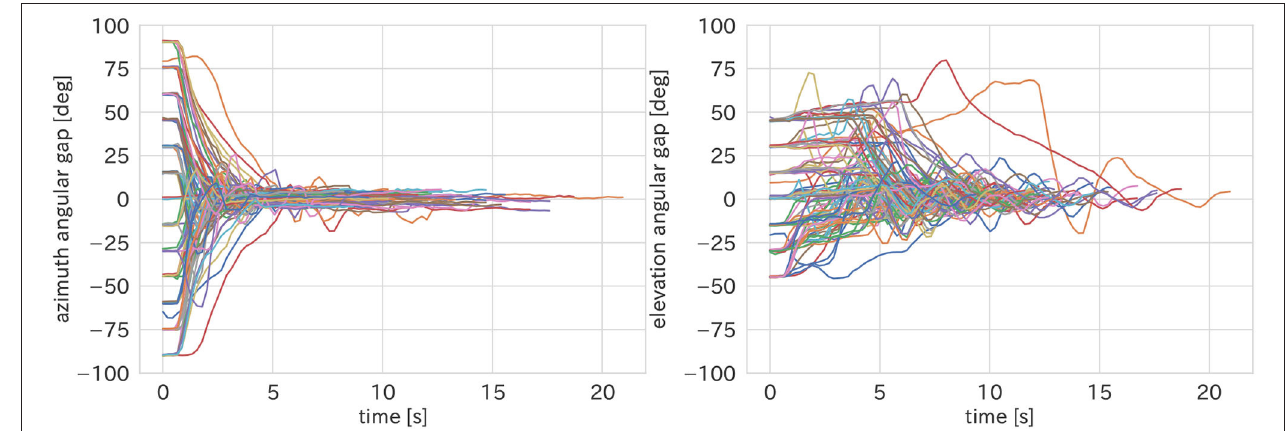
FIGURE 7 | Example of temporal changes of azimuthal and elevation angular gaps between the participant’s front and target direction in Experiment 1. Ninety-one trials were plotted. (Left) The temporal changes of the azimuthal angular gap. (Right) The temporal changes of the elevational angular